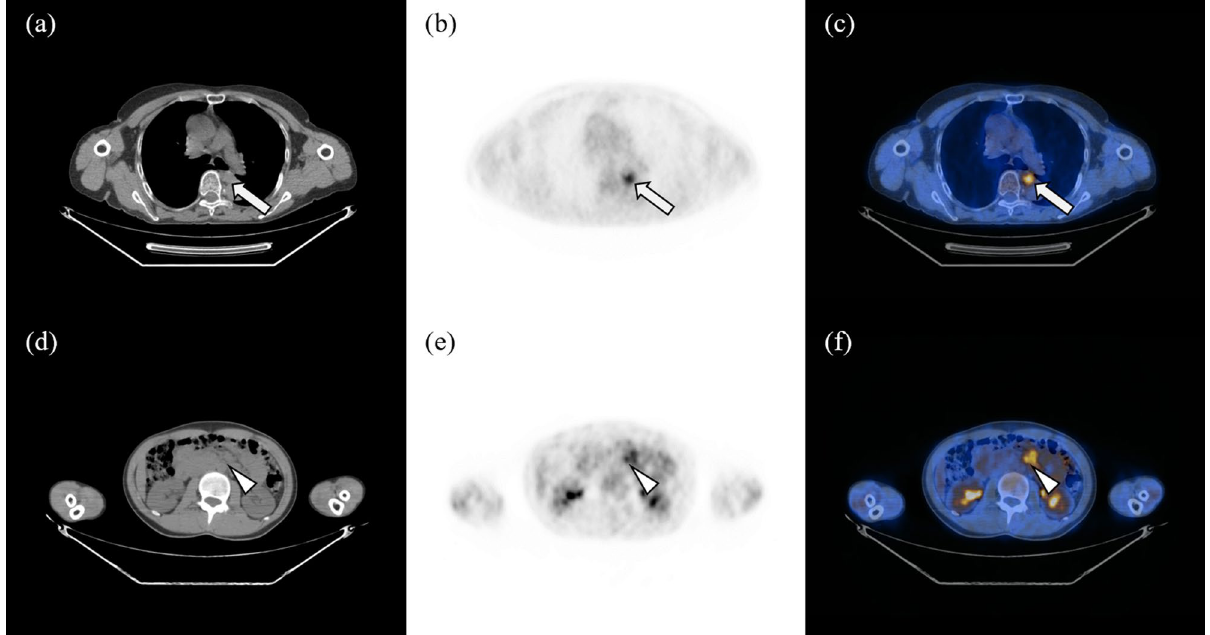
Figure 1. Non-contrast CT, F-18 FDG PET, and fusion images of two patients with correct upstaging by F-18 FDG PET/CT. ( a – c ) First, a 71-year-old female patient diagnosed with gastric MALT lymphoma was classified as modified Ann Arbor stage IE with the exception of F-18 FDG PET/CT during initial workup. F-18 FDG PET/CT showed a hypermetabolic paraesophageal lymph node consistent with lymphoma involvement (arrow, SUV max 4.53). The hypermetabolic paraesophageal lymph node was not histopathologically confirmed, and the patient was clinically upstaged from clinical stage IE to IIIE. ( d – f ) Second, a 23-year-old female patient diagnosed with gastric MALT lymphoma was classified as modified Ann Arbor stage IE with the exception of F-18 FDG PET/CT during initial workup. F-18 FDG PET/CT showed a hypermetabolic mesenteric lymph node with high possibility of lymphoma involvement (arrow head, SUV max 3.98). The hypermetabolic mesenteric lymph node was not histopathologically confirmed, but the clinical stage of the patient was changed from